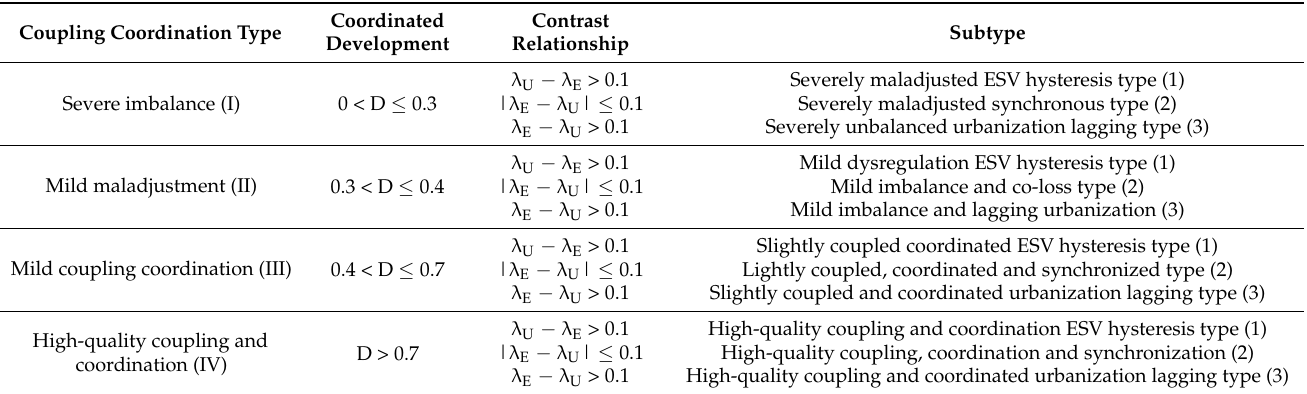
Table 3. Judgment criteria for coupling